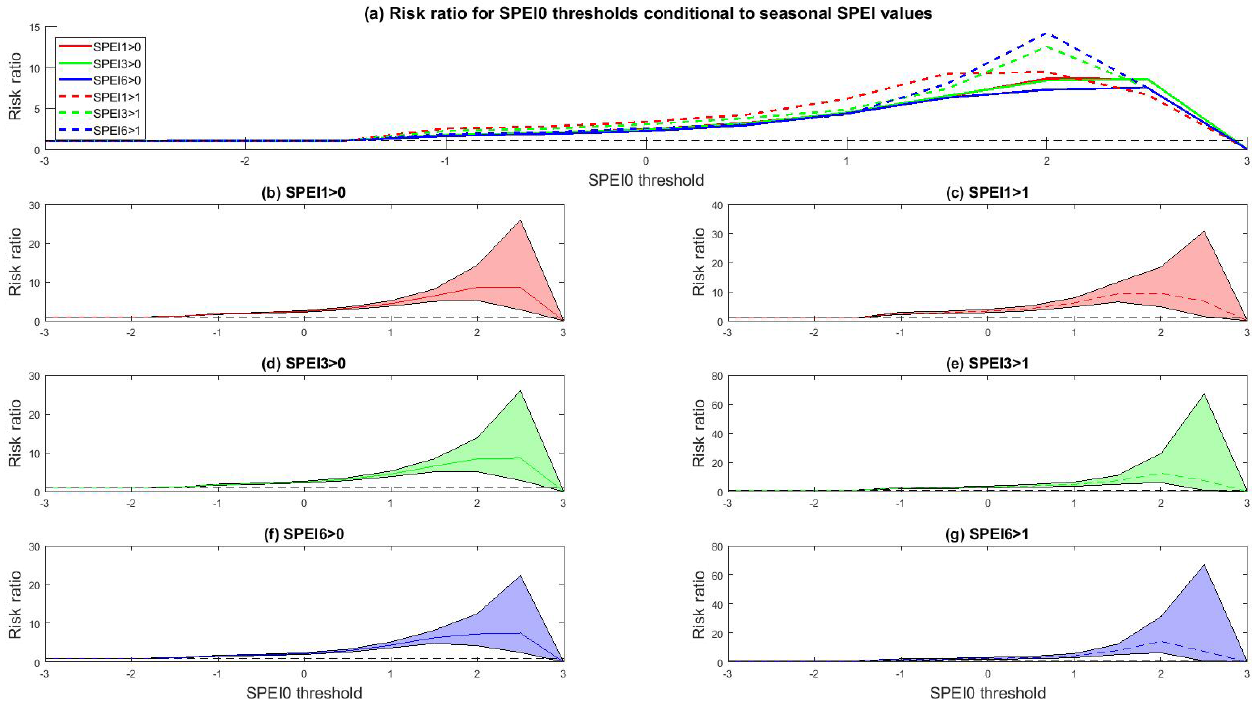
Figure 8. Risk ratio between F and NF for given SPEI0 thresholds conditional to seasonal SPEI values (SPEI1 > 0, red solid; SPEI > 1, red dashed; SPEI3 > 0, green solid; SPEI3 > 1, green dashed; SPEI6 > 0, blue solid; SPEI6 > 1, blue dashed) (a) and their confidence intervals are shown (b–g) . The horizontal dashed line shows the risk ratio of